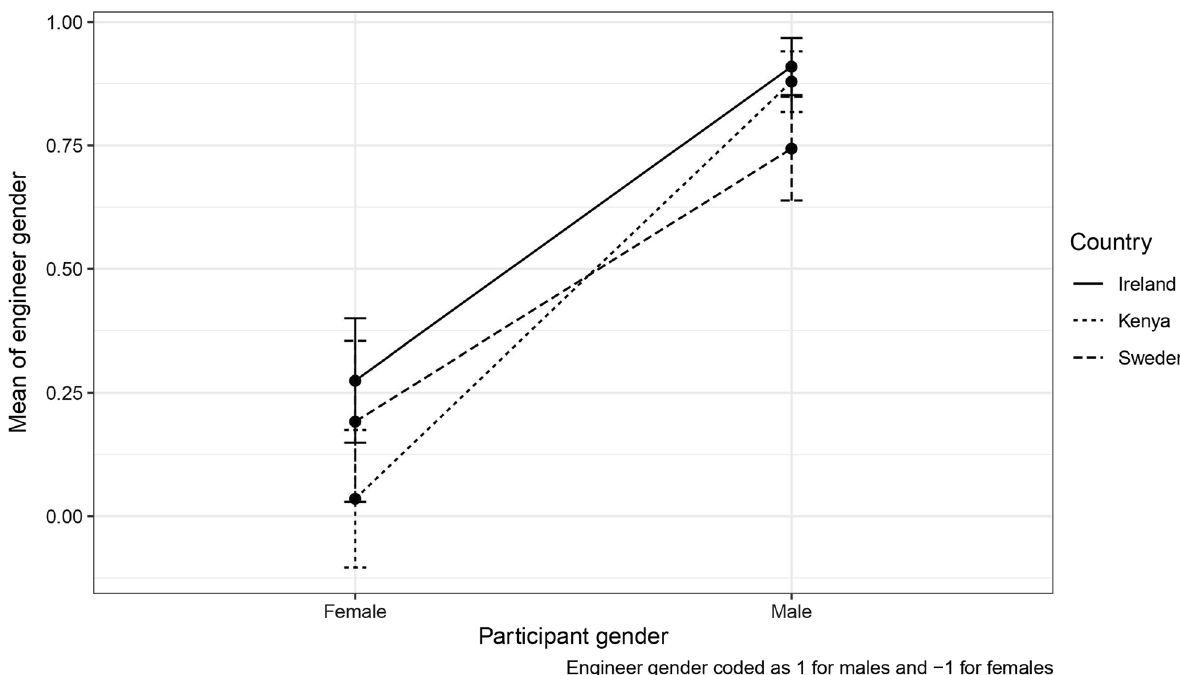
Fig. 1 Interaction between students’ gender and the country they were studying in and the probability that they would draw a male engineer. Coefficients greater than 0 indicate a higher probability of drawing a male engineer. If a coefficient was negative, it would have indicated an increased probability of drawing a female